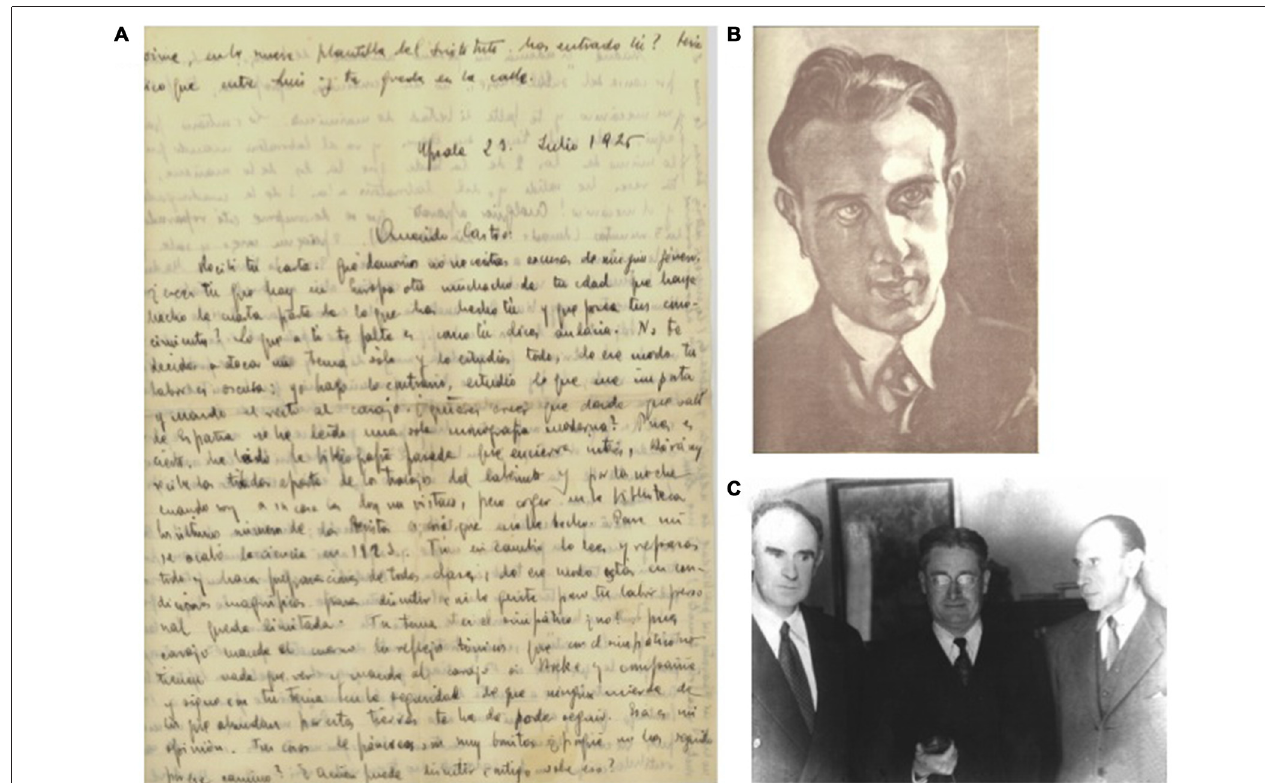
FIGURE 4 | Some proofs of the long-term friendship developed by Fernando de Castro with other disciples and visitors of the laboratory of Santiago Ramón y Cajal. (A) Manuscript letter from Rafael Lorente de Nó to Fernando de Castro describing the excellent formation and situation of de Castro in the neuroscientific panorama of the mid 1920’s. (B) Original charcoal portrait of Fernando de Castro by Ferenc Miskolzy (made in 1926, in Madrid), Hungarian painter and brother of the founder of modern Hungarian Neurology, Deszo Miskolzy, disciple and translator of Cajal’s books and close friend of de Castro for years. The painter came to Spain because he wanted to visit exiled last Austro-Hungarian empress, Zita, exiled in Spain. Following recommendations of his brother Deszo, he visited Fernando de Castro at Madrid, who showed him his scientific drawings and his deep interest and knowledge in Art. The painter gifted this charbon portrait to the Spanish neuroscientist as a proof of the close frienship of both Miskolzy brothers and Fernando de Castro. (C) Madrid (Spain), December 1958, from the left to the right, Florencio Bustinza (1902–1982; born at Liverpool, pharmacologist and profesor of Biology at Madrid), Sir Howard Florey (Nobel Prize in Physiology or Medicine 1945) and Fernando de Castro. Bustinza was personal friend of Sir Alexander Fleming and Sir Howard Florey since 1948, and Fernando de Castro kept frienship with the latter since his time at Cajal’s laboratory to learn histological technique during the mid 1920s, (A–C) are part of Archive Fernando de Castro.